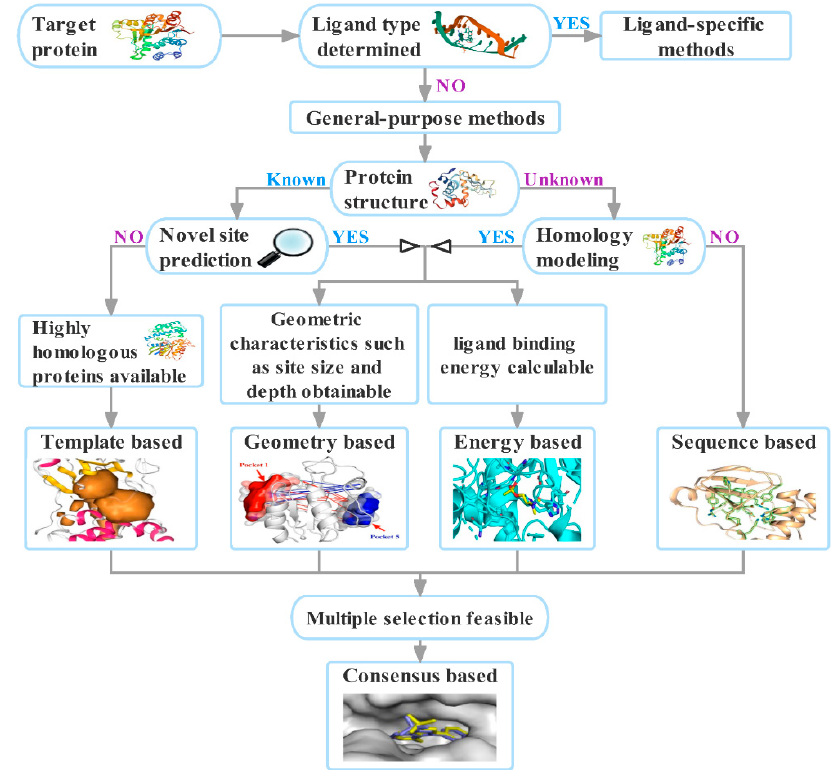
Figure 5. Process for choosing appropriate binding site identification methods.